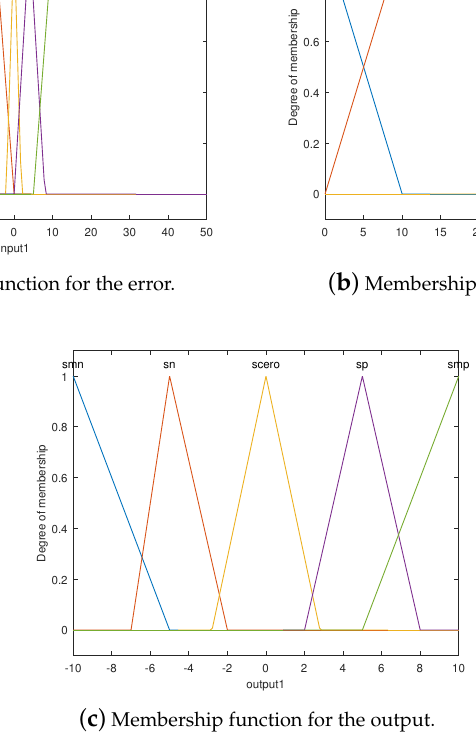
Figure 7. Membership functions proposed for the fuzzy